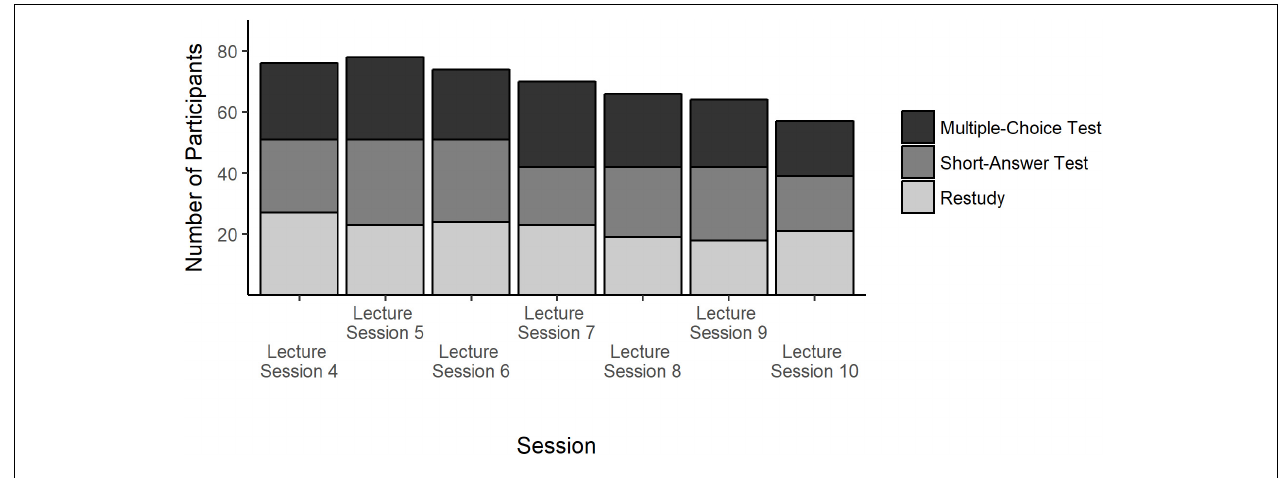
FIGURE 1 | Participation by condition and